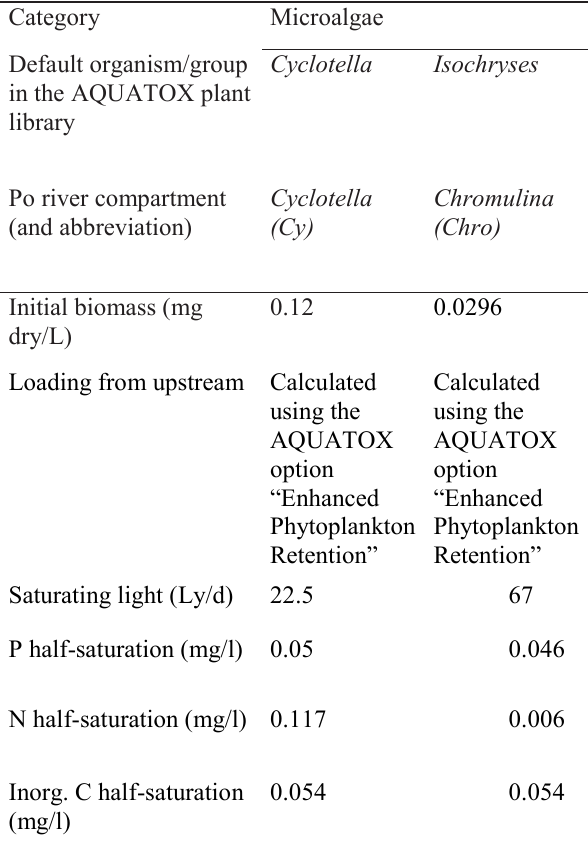
Table 2. Initial conditions for algae (Grechi et al.,